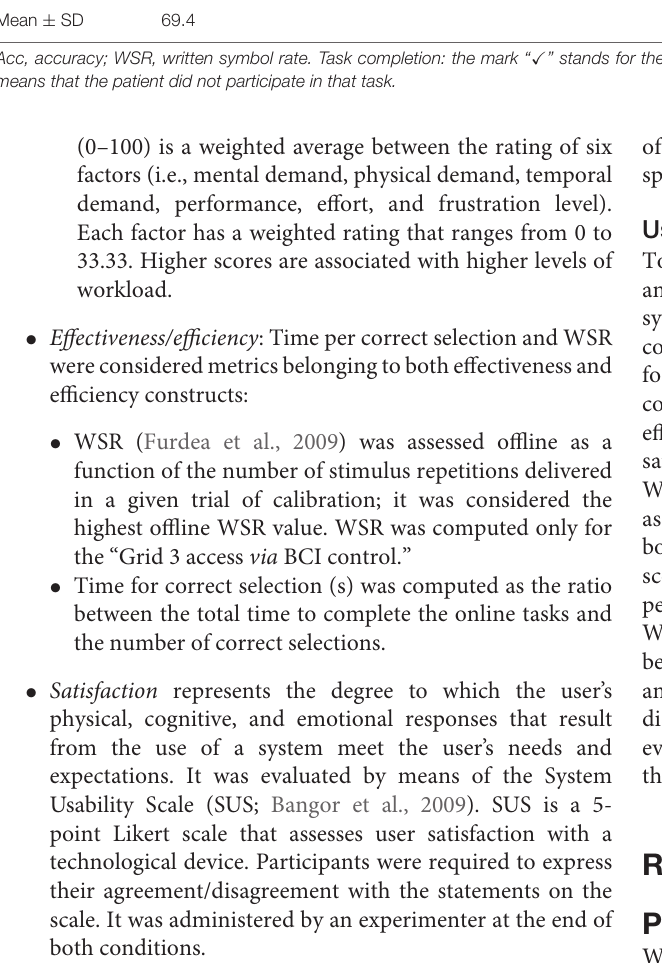
Grid 3 access via AT